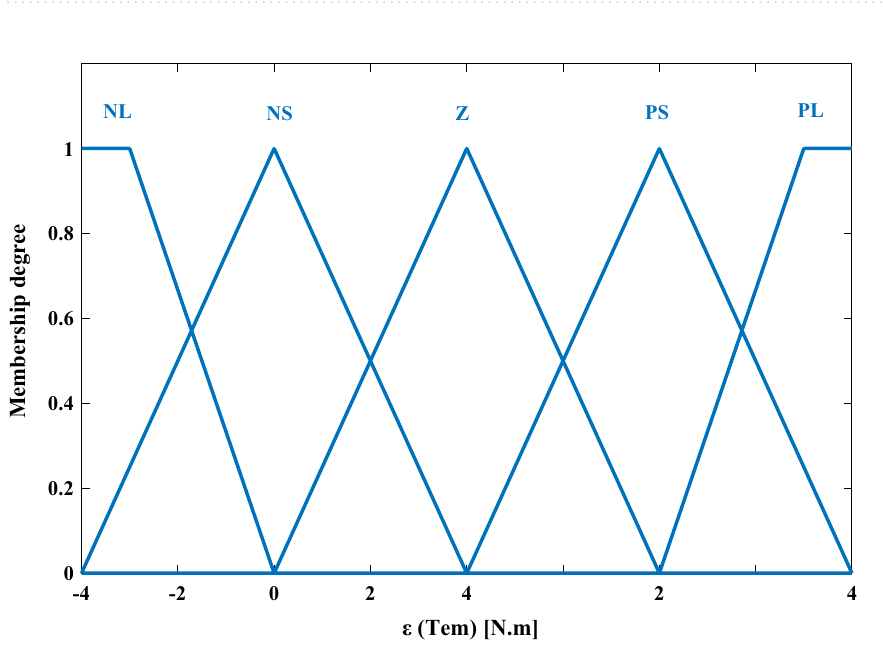
Figure 3. The fuzzy membership functions of ε φ .